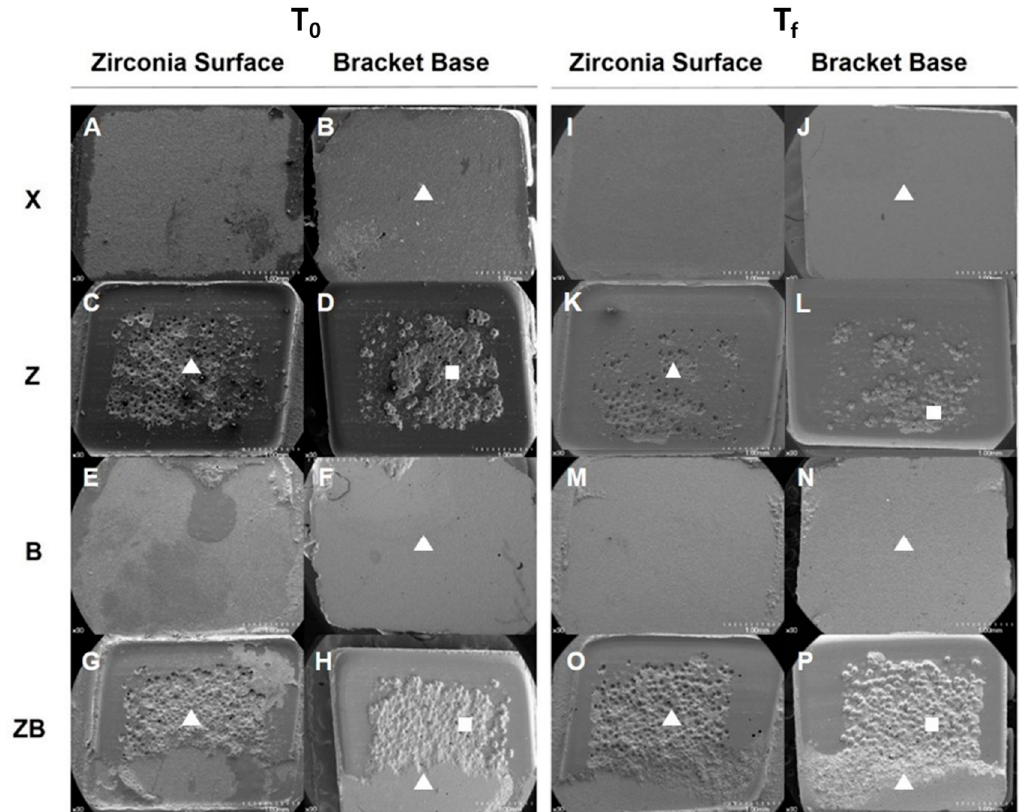
Figure 4. Representative SEM images of bonding interface (×30). Adhesive failure surfaces of zirconia ( A , C , E , G ) and bracket ( B , D , F , H ) in case of T 0 . Adhesive failure surfaces of zirconia ( I , K , M , O ) and bracket ( J , L , N , P ) in case of T f . triangle (resin); square (captured resin between the retention beads). ( A , E , I , M ) showed adhesive failure at the zirconia-resin interface; ( C , K ) showed adhesive failure at the resin-bracket interface; ( G , O ) showed mixed failure at the zirconia-resin-bracket interface.